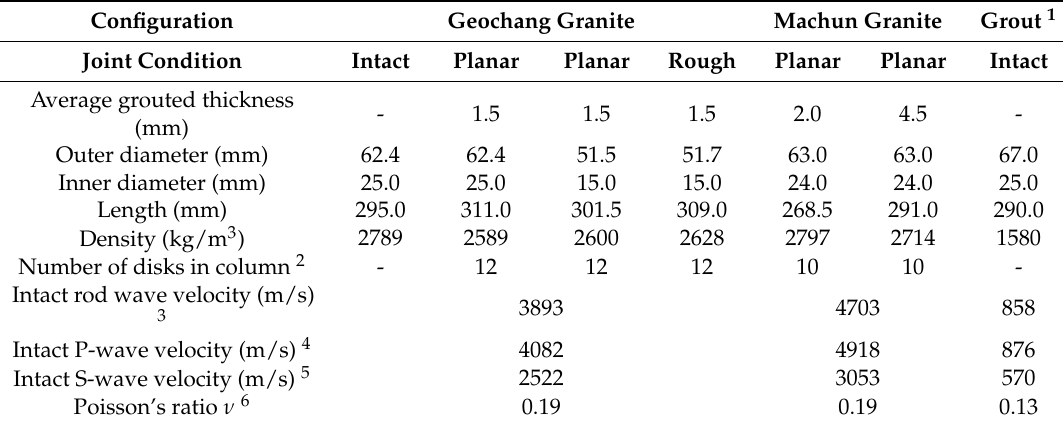
Table 1. Specification of rock specimens used in this